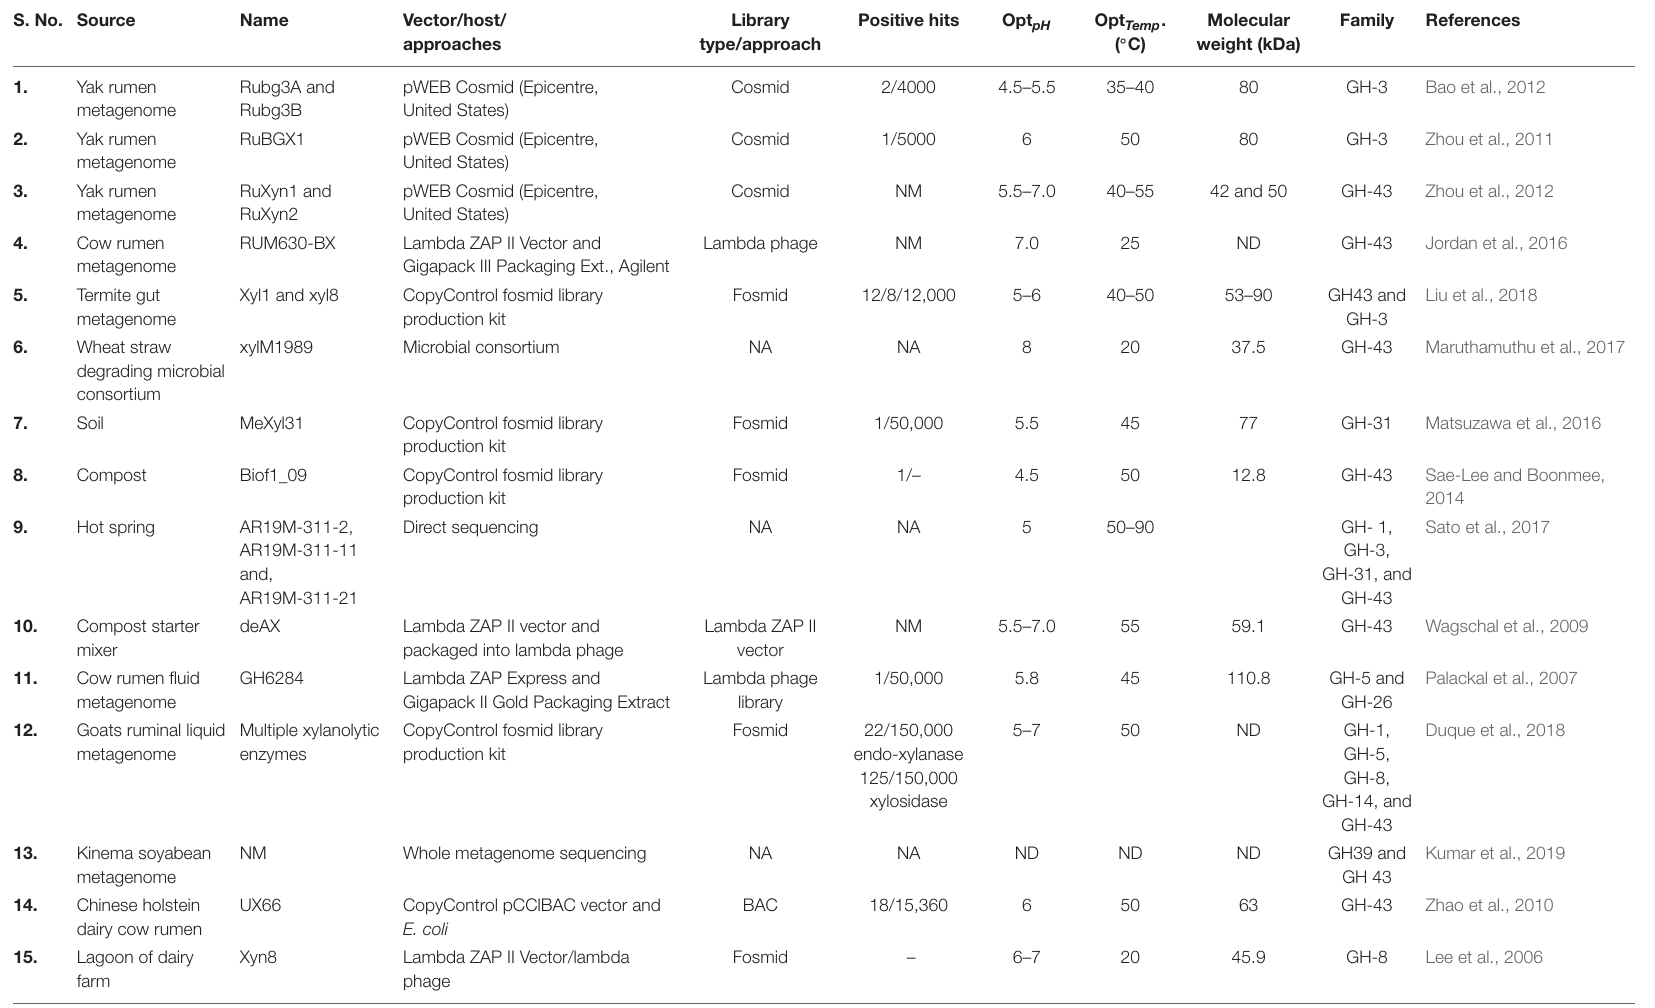
TABLE 2 | An update of metagenomic xylanolytic enzymes other than GH-10 and GH-11 xylanases. S. No.